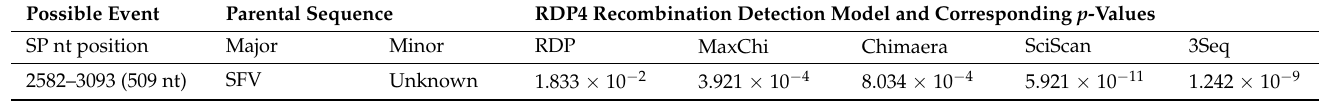
Table 6. Possible recombination events associated with currently described MIDV full genomes (ZRU080/14; ZRU089/14; ZRU044/17; ZRU059/17/1; ZRU075/17 and ZRU103/17) within the structural region. Only detection models with significant statistical support ( p < 0.05) are shown. Nucleotide positions corresponds to the structural proteins (C+E3+E2+6k+E1 excluding the 5 (cid:48) UTR and 3 (cid:48) UTR) of ZRU044/17. SFV Semliki Forest Virus (Genbank accession number CAA27742); nt =